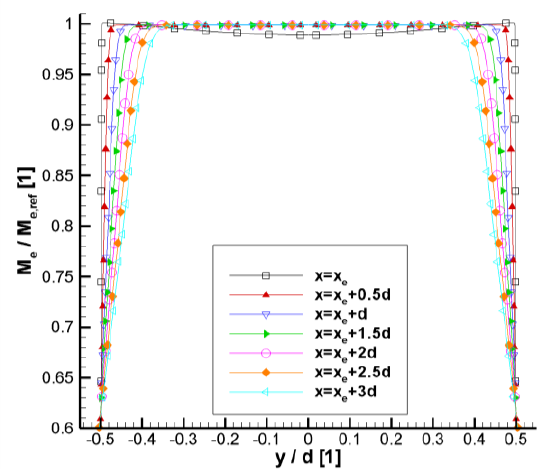
Fig. 3. Mach number across the nozzle exit from CFD (M e =